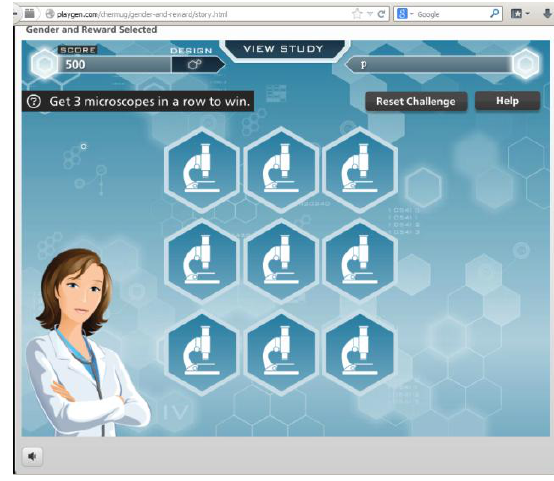
Figure 2. An example of the tic-tac-toe game mechanics.